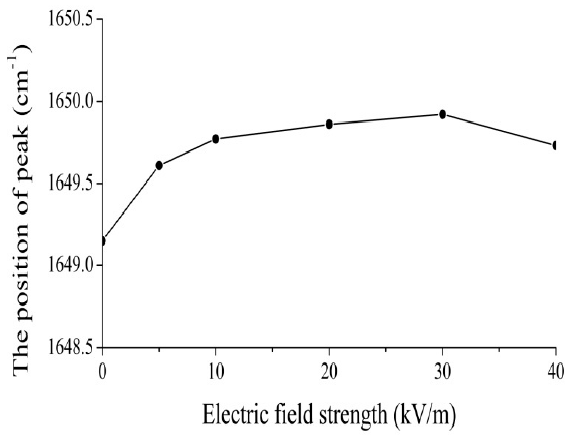
Figure 13. Changes in the position of a 1650-cm − 1 peak with increases to the externally applied voltage.